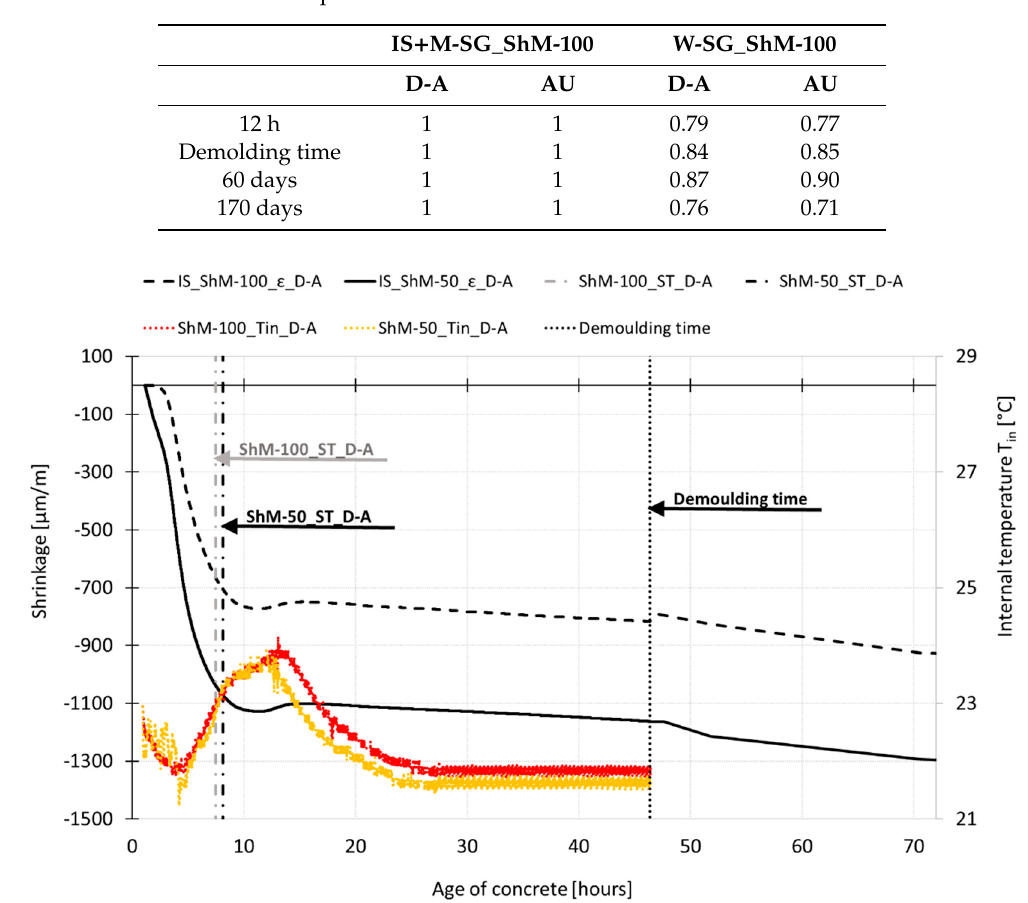
Table 4. Shrinkage values of the SCC HPC: Relative average values of shrinkage determined by different measurement techniques.